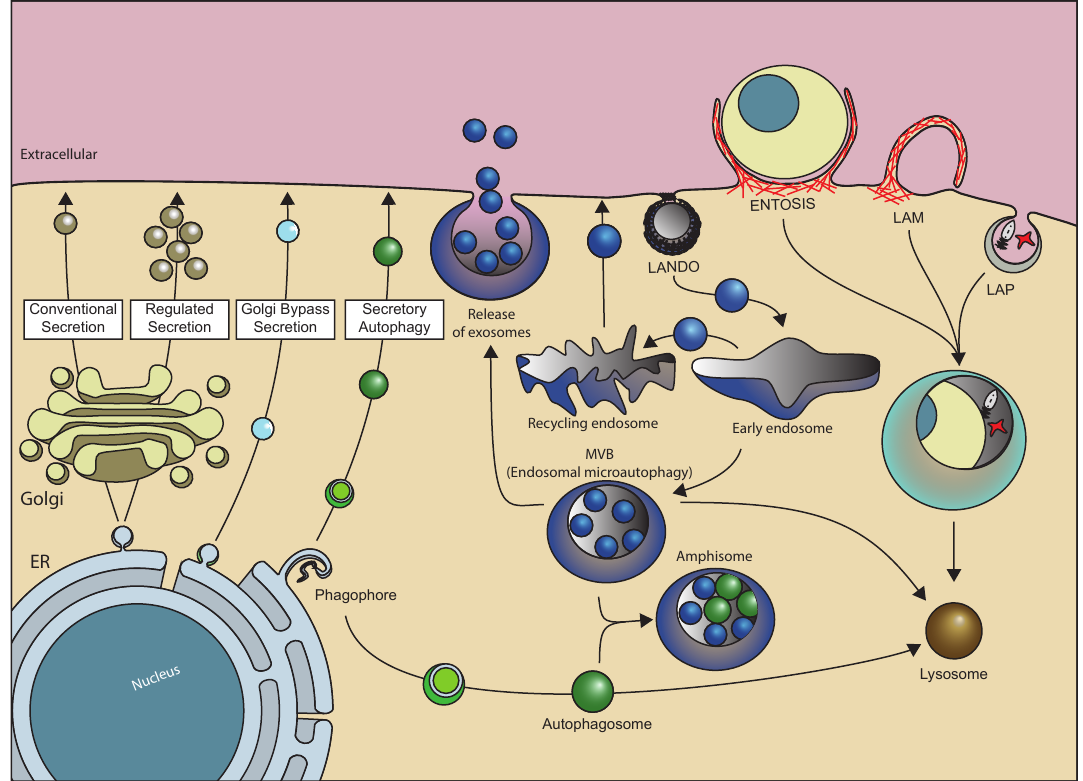
Figure 1. Overview of conventional and several non-conventional pathways where autophagy-related (ATG)8 proteins and their conjugation machinery are utilized. Briefly, ATG8 protein conjugation is important during macroautophagy where it facilitates cargo recruitment, closure of the autophagosome and degradation of the inner membrane. ATG8 proteins and their machinery are also shown to a ff ect protein secretion, including regulated secretion (Lysozyme, Glut4), Golgi-bypass secretion (CFTR), and secretory autophagy, which includes secretion of cytosolic interleukin 1 beta (IL-1 β ) and insulin-degrading enzyme (IDE). ATG8 proteins are found to be important for maturation of compartments following light chain 3 (LC3)-associated phagocytosis (LAP), entosis, micropinocytosis, and LC3-associated endocytosis (LANDO). Core components of the conjugation machinery have further been implicated in endosomal microautophagy and exosome